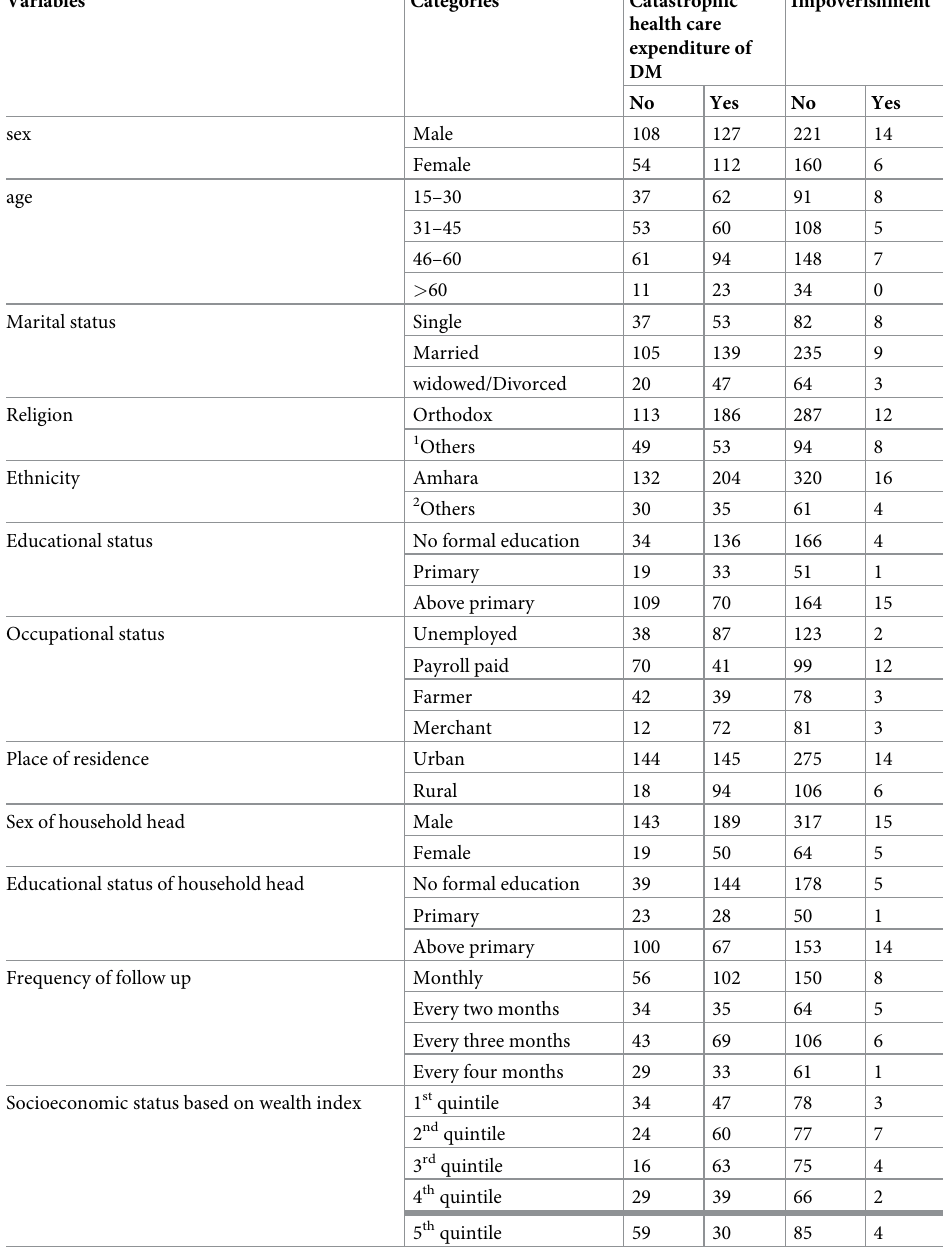
Table 3. Catastrophic health expenditure and impoverishment among diabetic patients in public hospitals of Bahir Dar city administration, Ethiopia, 2019.